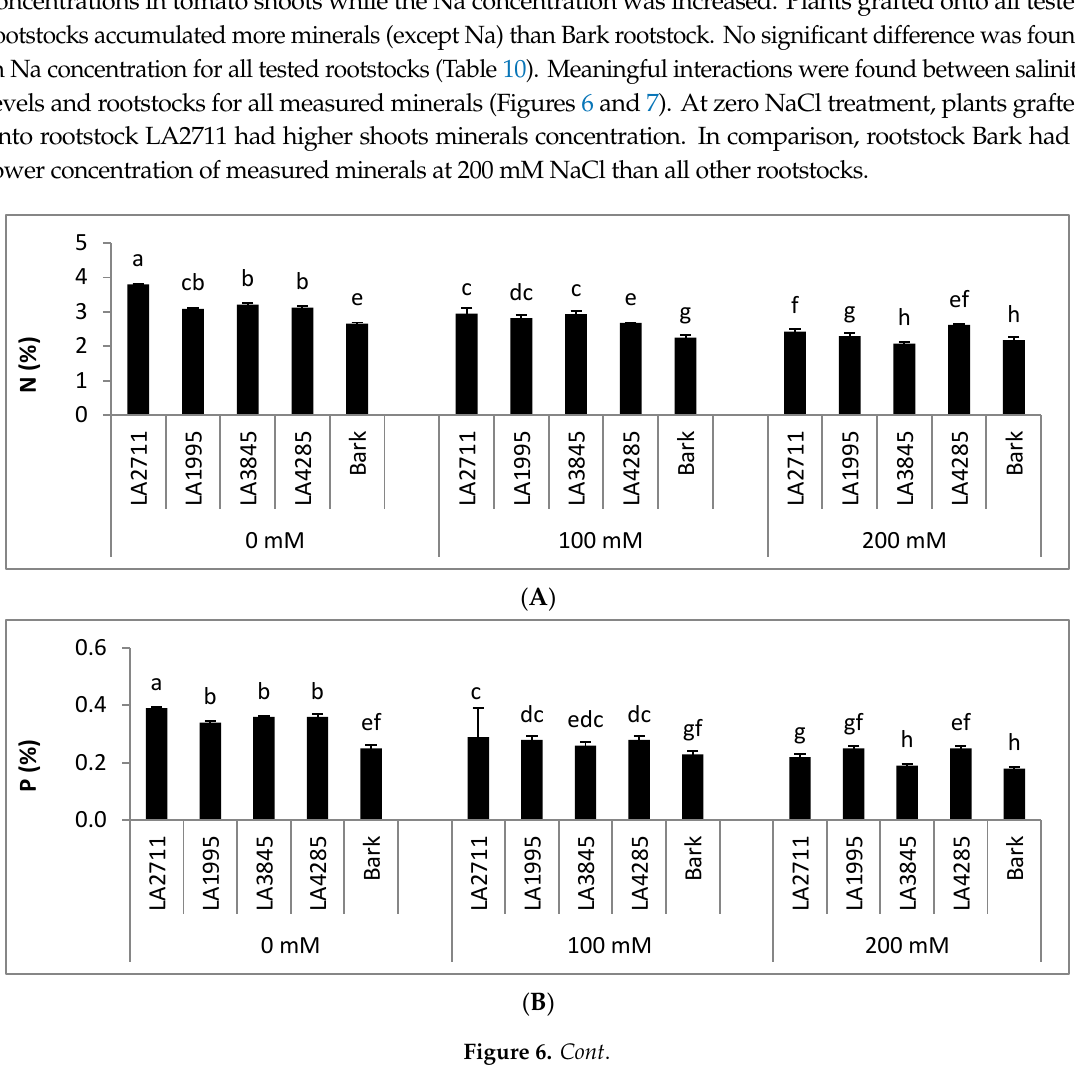
Table 8. Effect of salinity treatments, rootstocks and their interactions on fruits quality.